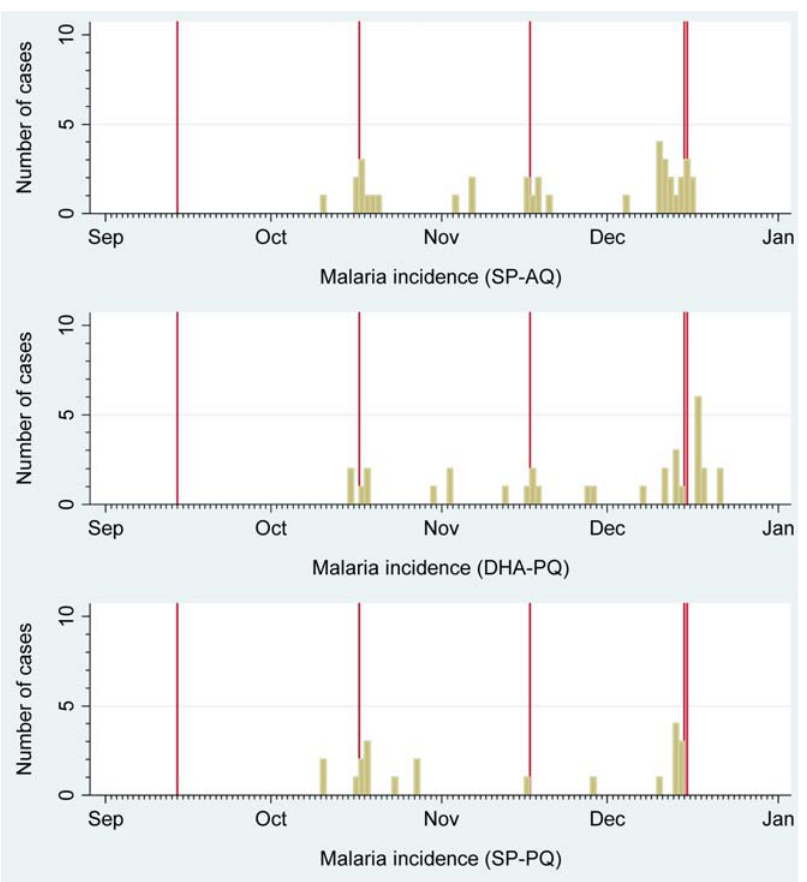
Figure 2. Malaria incidence during the study period. Incidence of first episode malaria associated with parasitaemia at any parasite density in the study area between September-December 2007. Single red lines indicate median date of the IPT rounds in September, October and November. Double red line indicates the median date of the December morbidity survey. One child had a second malaria episode in mid-November and 13 children had a second malaria episode detected at the survey in December (not shown).